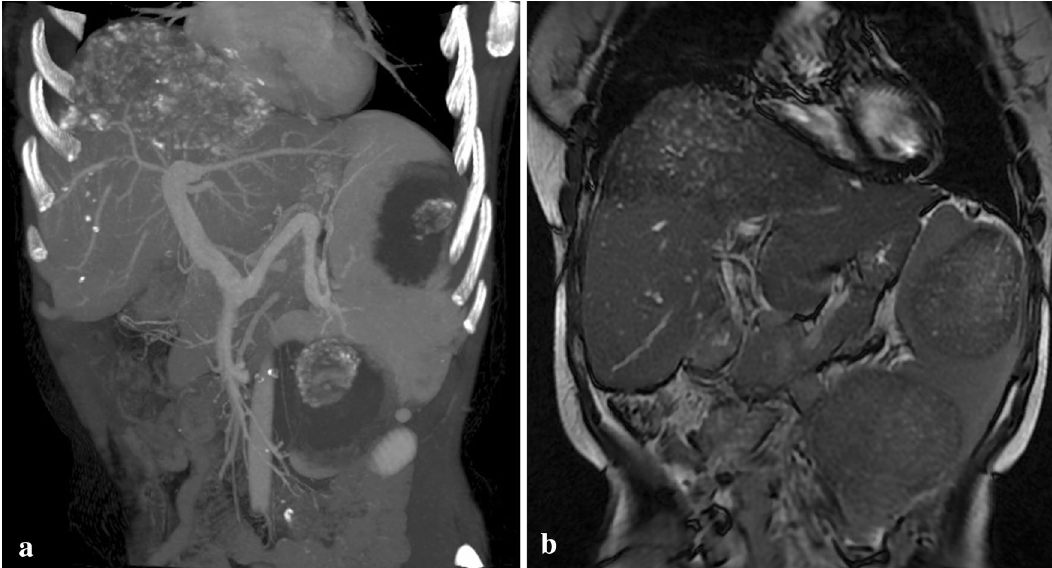
Figure 5. Two lesions were low density with nodular calcification in a coronary MSCT image ( a ) and heterogeneous intensity in a coronary T2-weighted MR image ( b ). This case also had hepatic